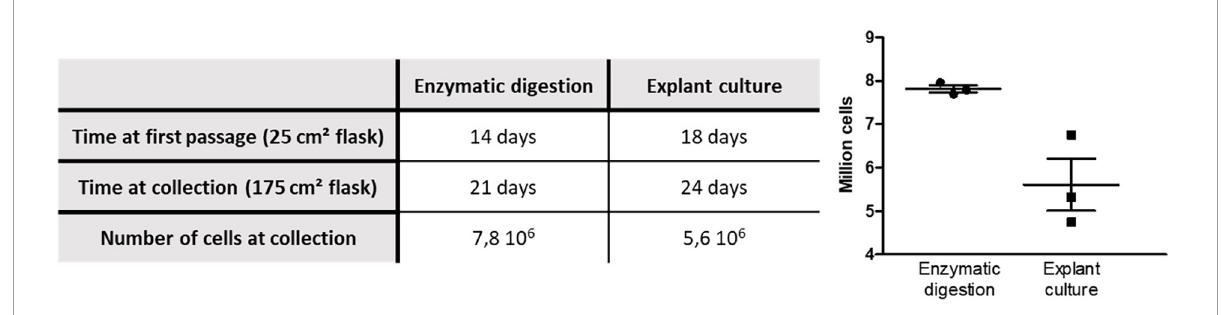
FIGURE2 Effects of the two methods of purification on the proliferation of